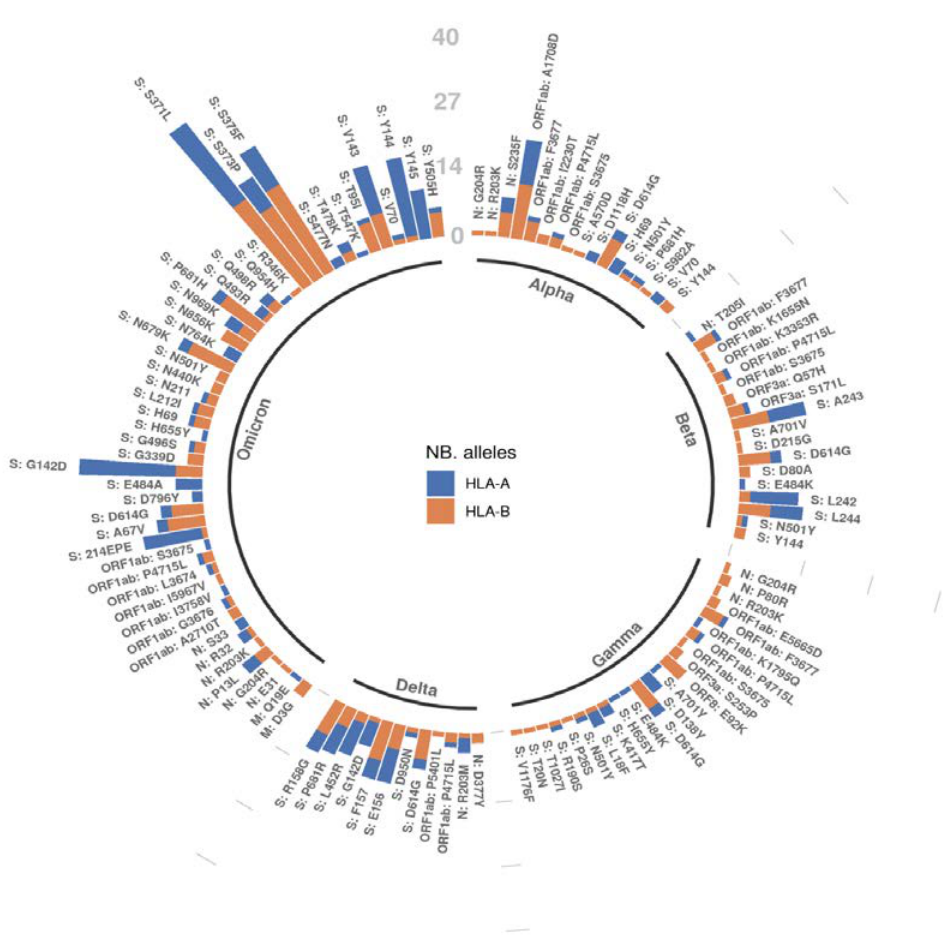
Figure 5. The number of HLA alleles per mutation for which there was a significant difference ( p - value < 0.05) using Table 2. For each mutation, all overlapping peptides of length 9 and 10 that overlap a given mutation were considered as candidate HLA-restricted epitopes.